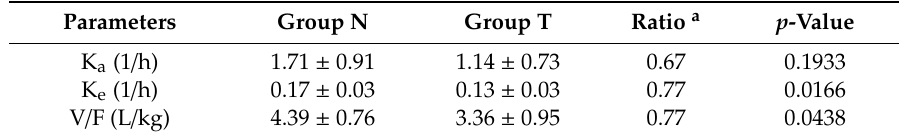
Table 2. The one-compartment model parameters of tadalafil in non-pretreated rats (Group N) and ticagrelor-pretreated rats (Group T). Values are represented as mean ± SD (n = 10).